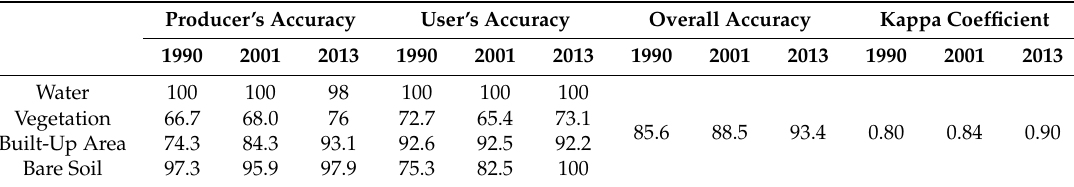
Summary of the error matrices for 1990, 2001, and 2013 using the ISODATA classification